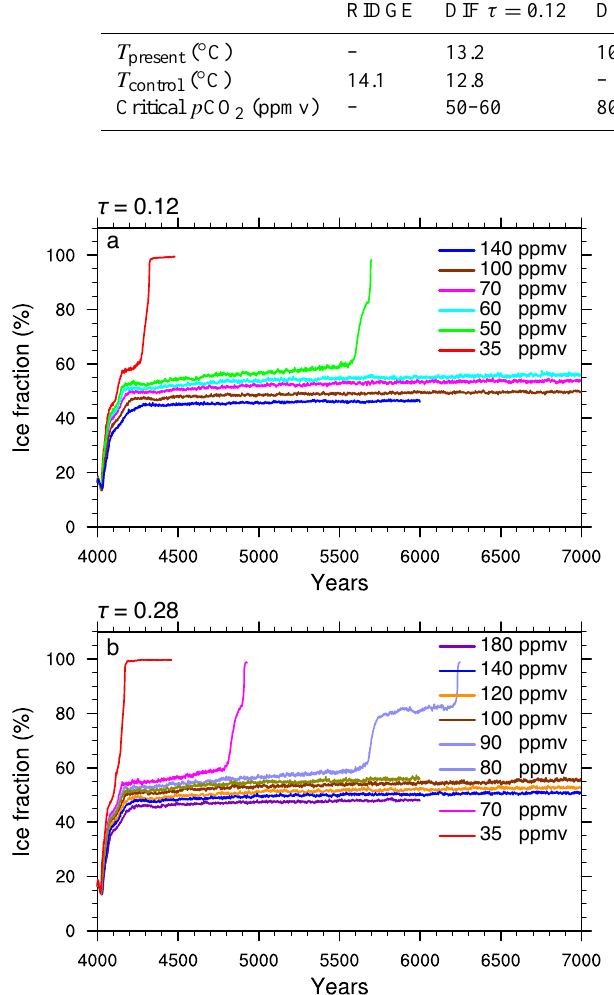
Fig. 4. Time series of sea-ice fraction (ratio of total sea-ice area to the surface area of the entire ocean) obtained for the branch runs for the 720Ma continental configuration. The values of τ are 0.12 in (a) and 0.28 in (b) . TSI is fixed to 0.94TSI 0 for all